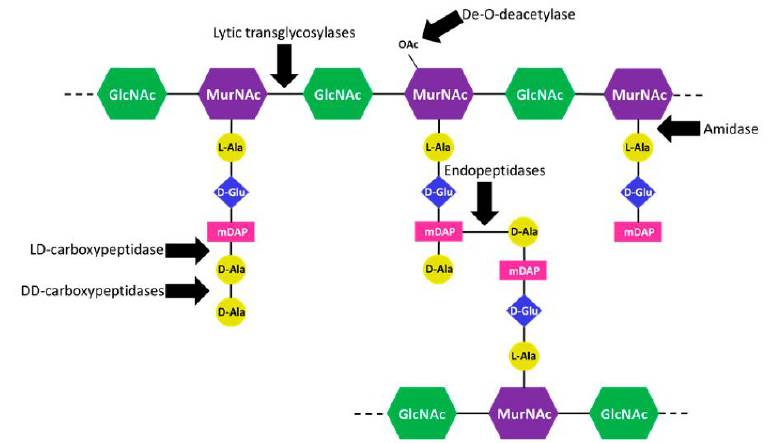
Figure 1. Cleavage site of gonococcal peptidoglycanases. Lytic transglycosylases cleave the β -1,-4 link between the N -acetylmuramic acid (MurNAc) and N -acetylglucosamine (GlcNAc) sugar moieties. DD-carboxypeptidases and a LD-carboxypeptidase shorten the peptide stem. The LD-carboxypeptidase can only act on four amino acid peptide stems. An N -acetylmuramyl L-alanine amidase cleaves the stem off the MurNAc residue. Endopeptidases cut the crosslinks between peptide chains from adjacent PG strands. A PG de- O -deacetylase removes the O -acetyl group from MurNAc. Without de-acetylation, the lytic trans-glycosylases cannot cleave the MurNAc bond.